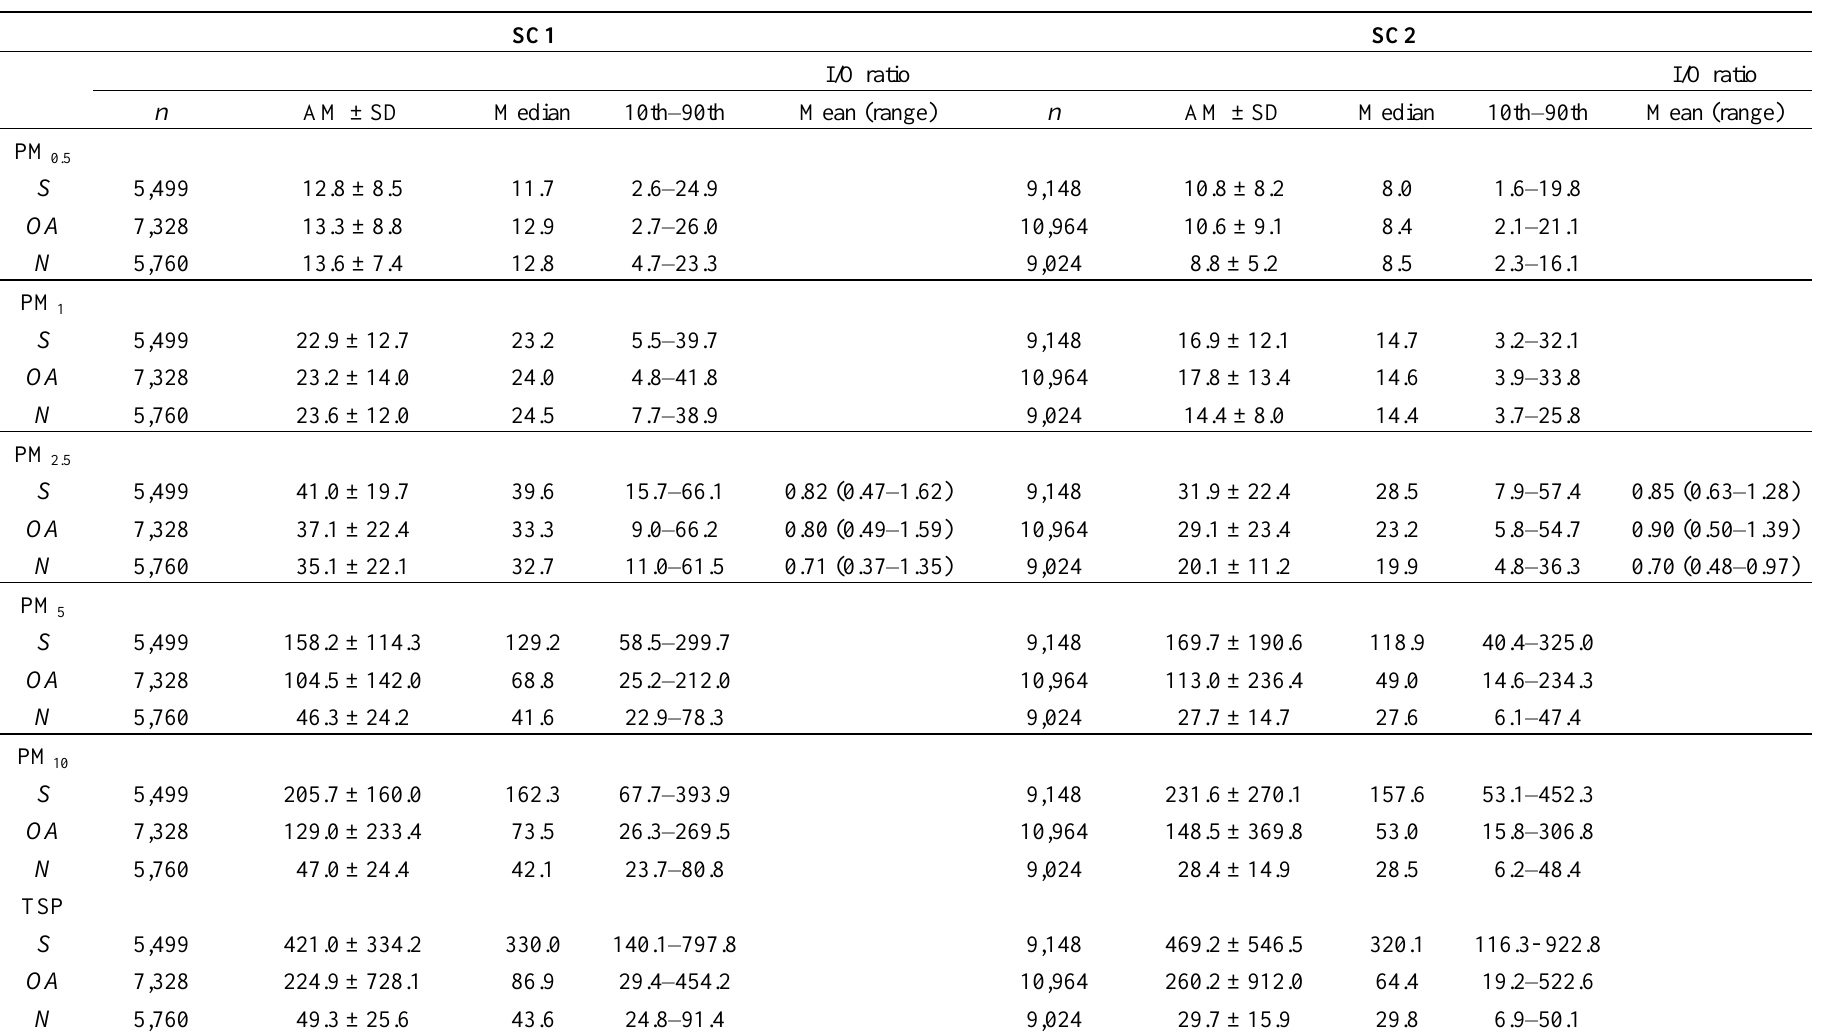
Table 4. Descriptive statistics for the 5-d indoor PM (µg/m 3 ) and CO The PM and CO I/O ratios for the same periods are also reported; n = number of continuous data recorded throughout the sampling 2.5 2 sessions, AM = arithmetic mean, SD = standard